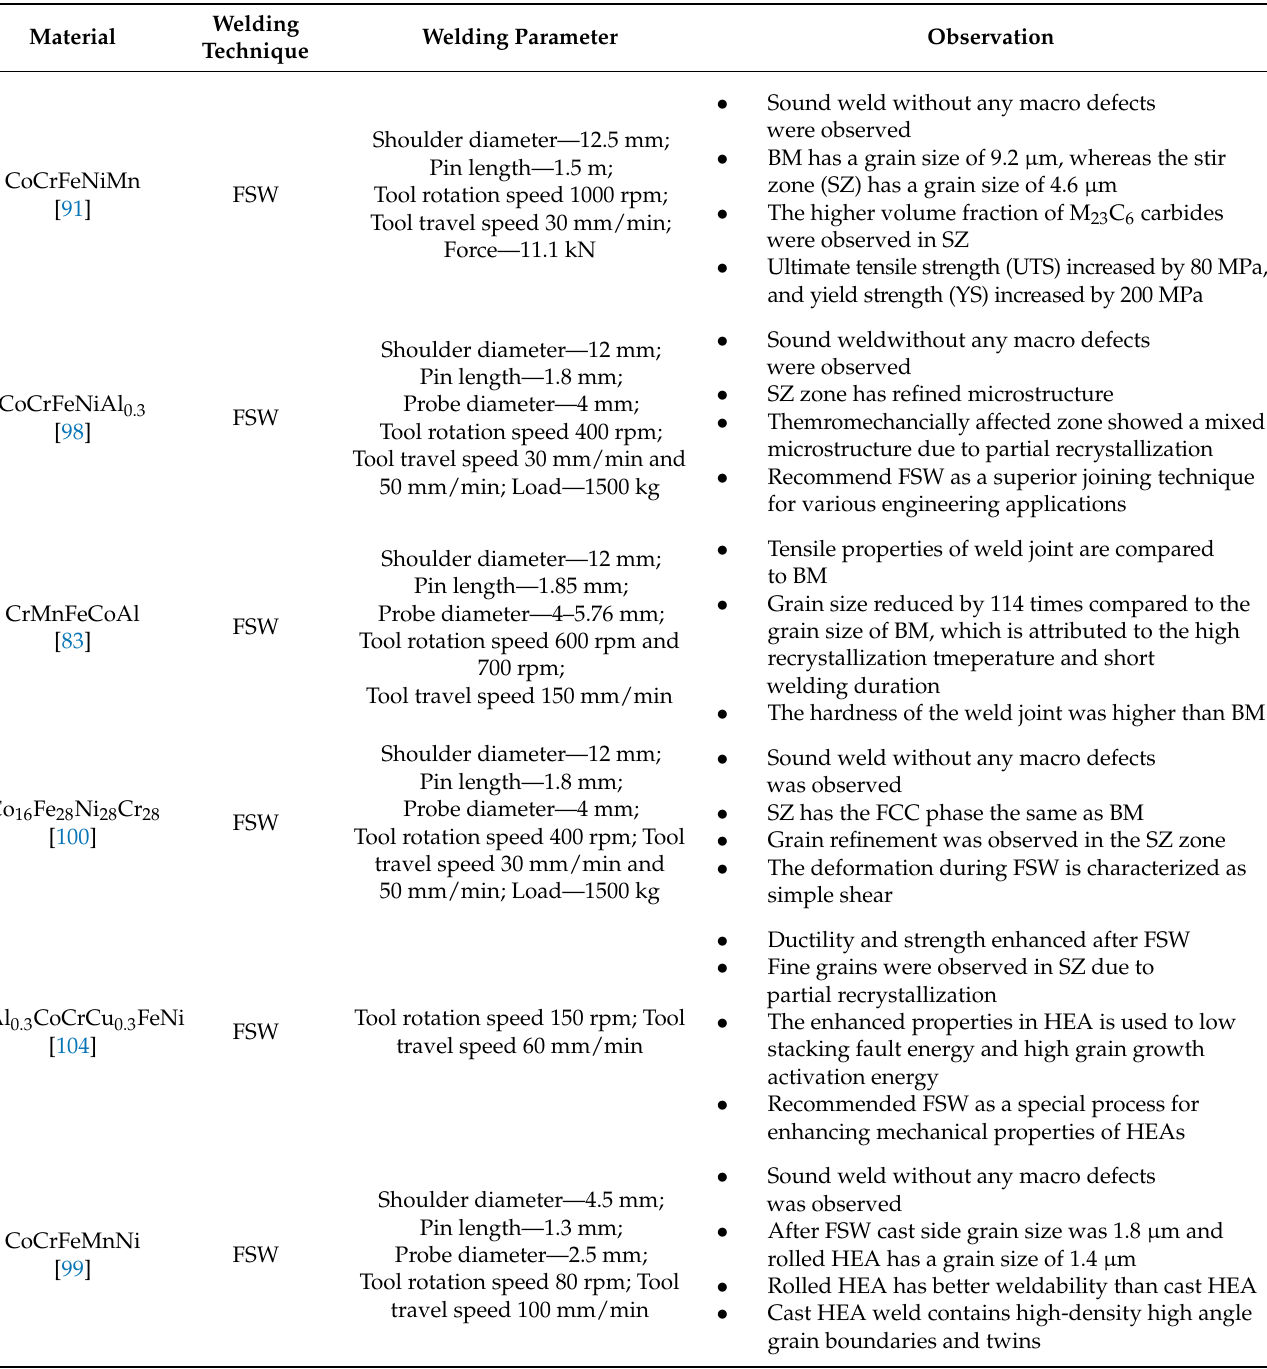
Table 2. Mechanical properties and microstructural features of solid-state welded